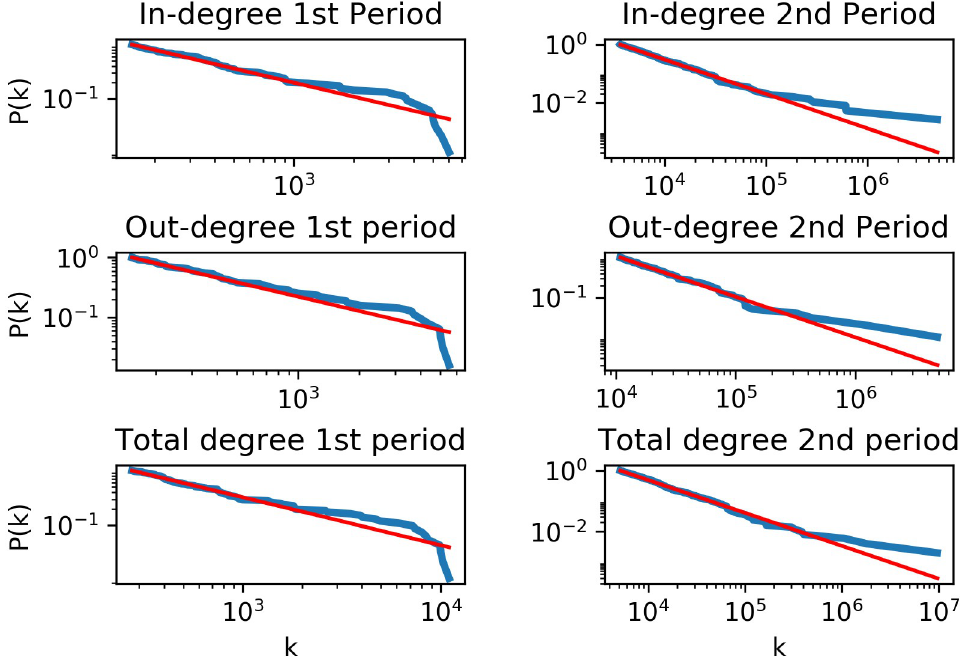
Fig 1. Degree distributions empirically calculated separately for the two periods and shown as blue lines in the form of complementary cumulative distribution functions (CCDFs). The red lines show a power law function with an exponent of